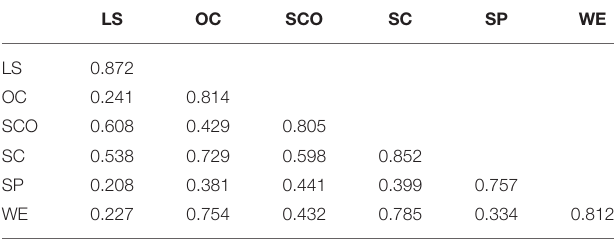
TABLE 3 | Discriminant validity